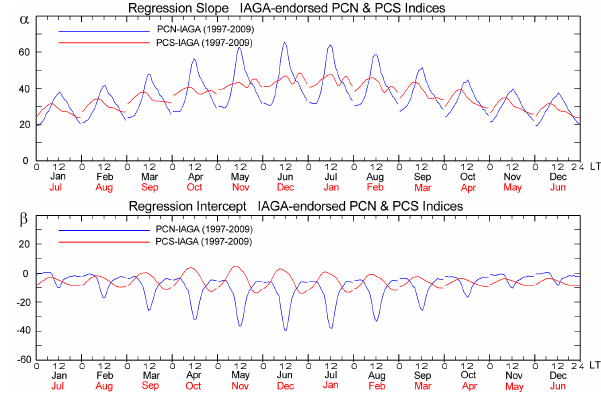
Figure 9. Slopes (upper field) and intercepts (bottom field) from PCN derivation provided in http://pc-index.org (IAGA endorsed) (red lines), derived by Troshichev et al. (2006) (green lines), and derived by DMI (blue lines). Each field has 12 columns to display monthly means of the variations 00:00 to 24:00UT.